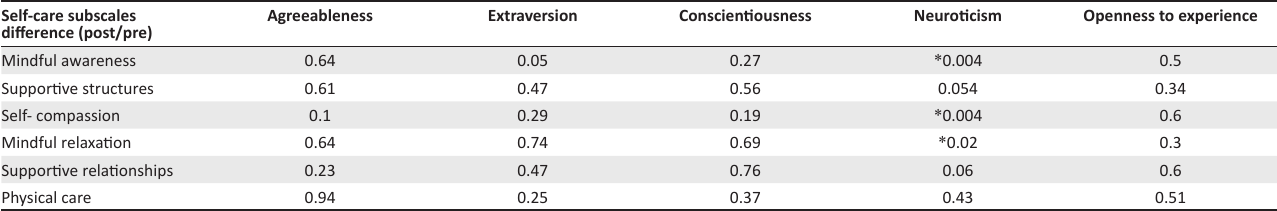
TABLE 2: Self-care subscales difference (post-pre) adjusting for personality traits. Self-care subscales difference (post/pre)